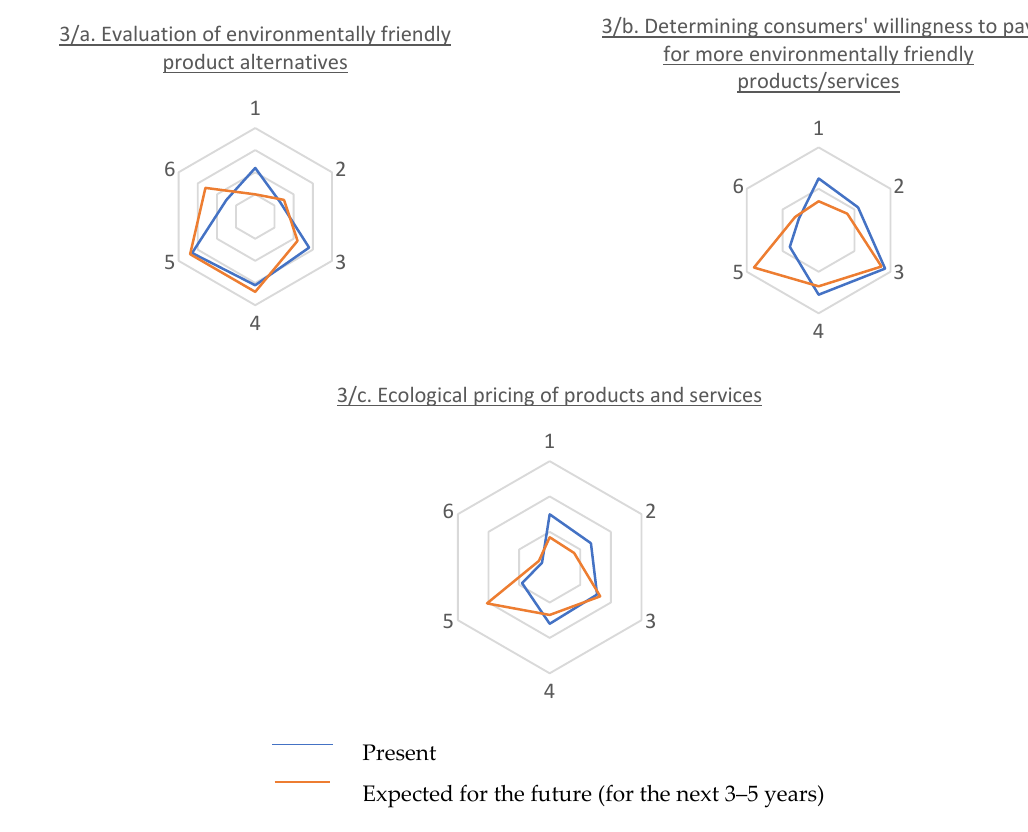
Figure 6. The spider web diagram of the scores given by the respondents at Stage 3 of becoming sustainable. Source: edited by authors.